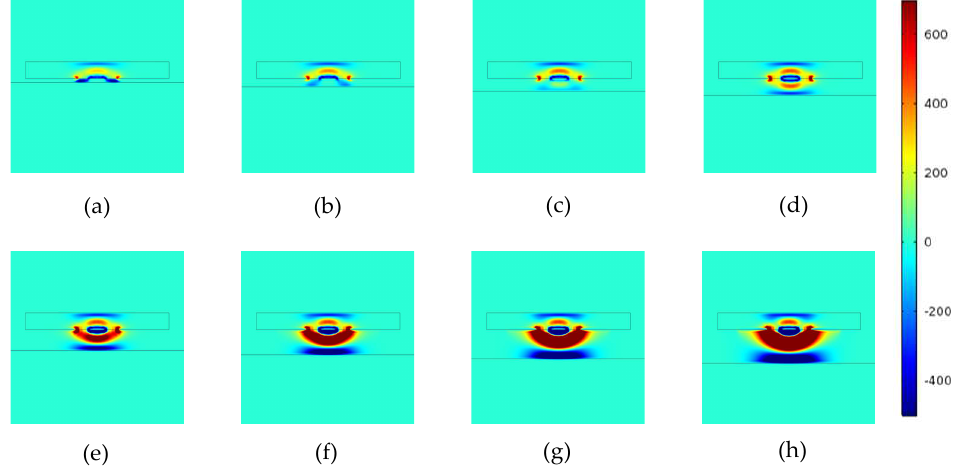
Figure 7. MSD variations with increased lift-offs for a grounded conducting specimen. MSDs at ( a ) 0.5 mm, ( b ) 1 mm, ( c ) 1.5 mm, ( d ) 2.0 mm, ( e ) 2.5 mm, ( f ) 3.0 mm, ( g ) 3.5 mm, and ( h ) 4.0 mm lift-offs.